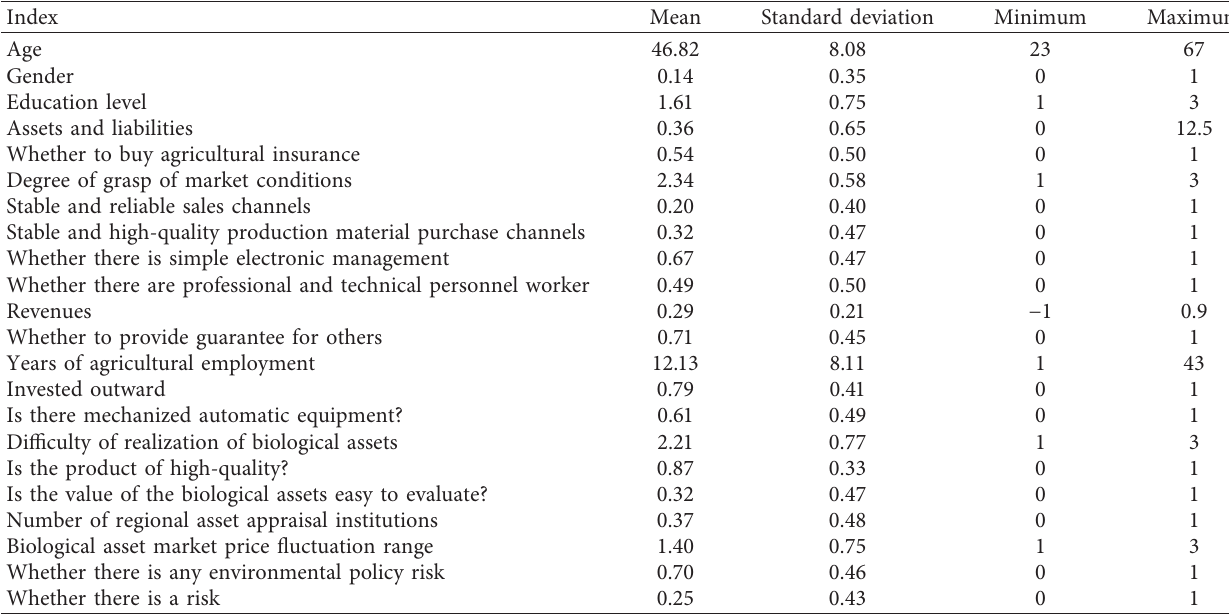
Table 4: Data descriptive statistical analysis.